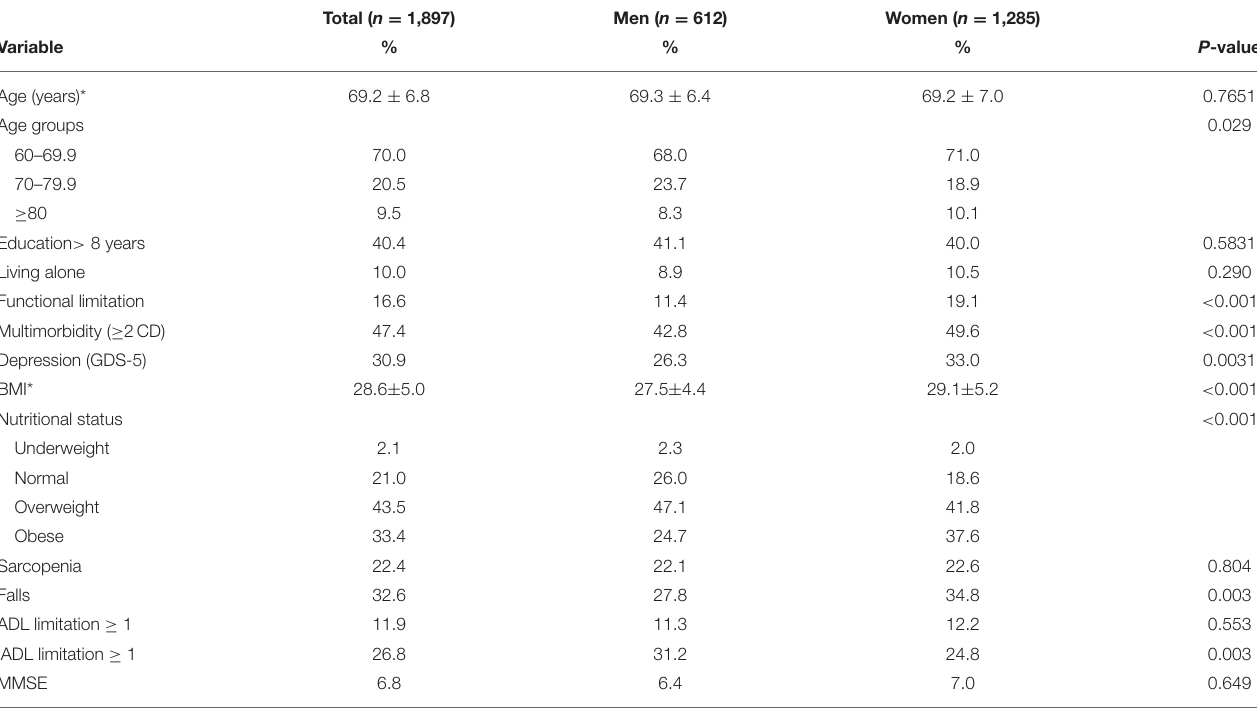
TABLE 1 | Baseline characteristics of the sample.